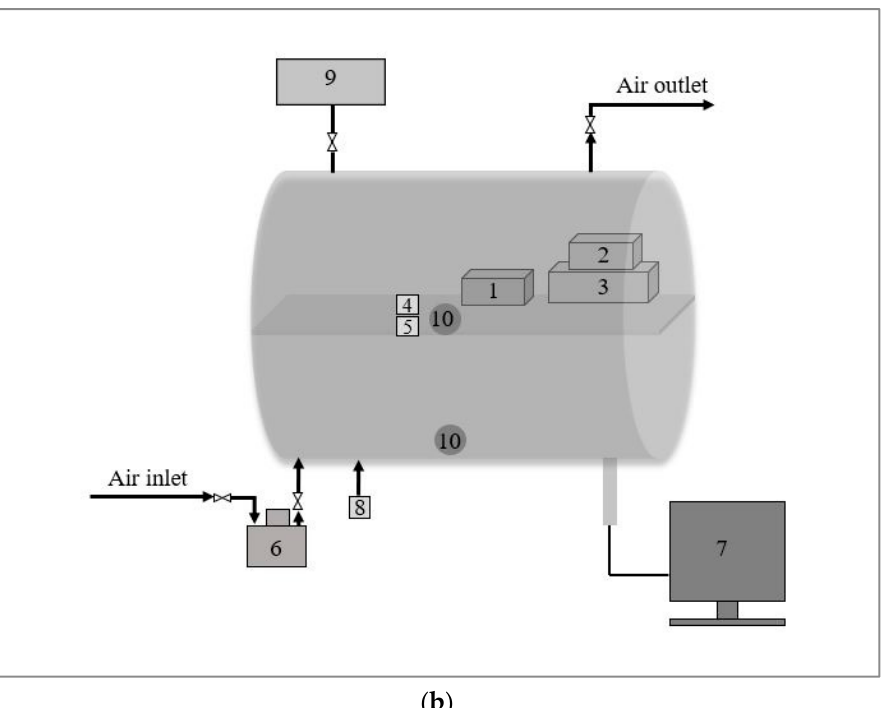
Figure 6. ( a ) Experimental setup in the radon chamber for the calibration of the Pylon AB5 monitor: 1—the AlphaGuard DF2000 monitor; 2—the Radon Scout monitor; 3—the Pylon monitor; 4—humidity sensor; 5—fan. ( b ) Diagram of the radon chamber, its accessories and the connections used for monitor calibrations: 1—the AlphaGuard DF2000 monitor; 2—the Radon Scout monitor; 3—the customer monitor; 4 and 5—temperature and humidity sensors, respectively; 6—radon activity-decaying source in a closed steel recipient; 7—computer with specific software; 8—air pressure sensor; 9—vacuum pump; 10—two fans used for the uniformity of the radon distribution. Table 3. The results obtained in the calibration of the Pylon AB5 radon monitor. Crt.